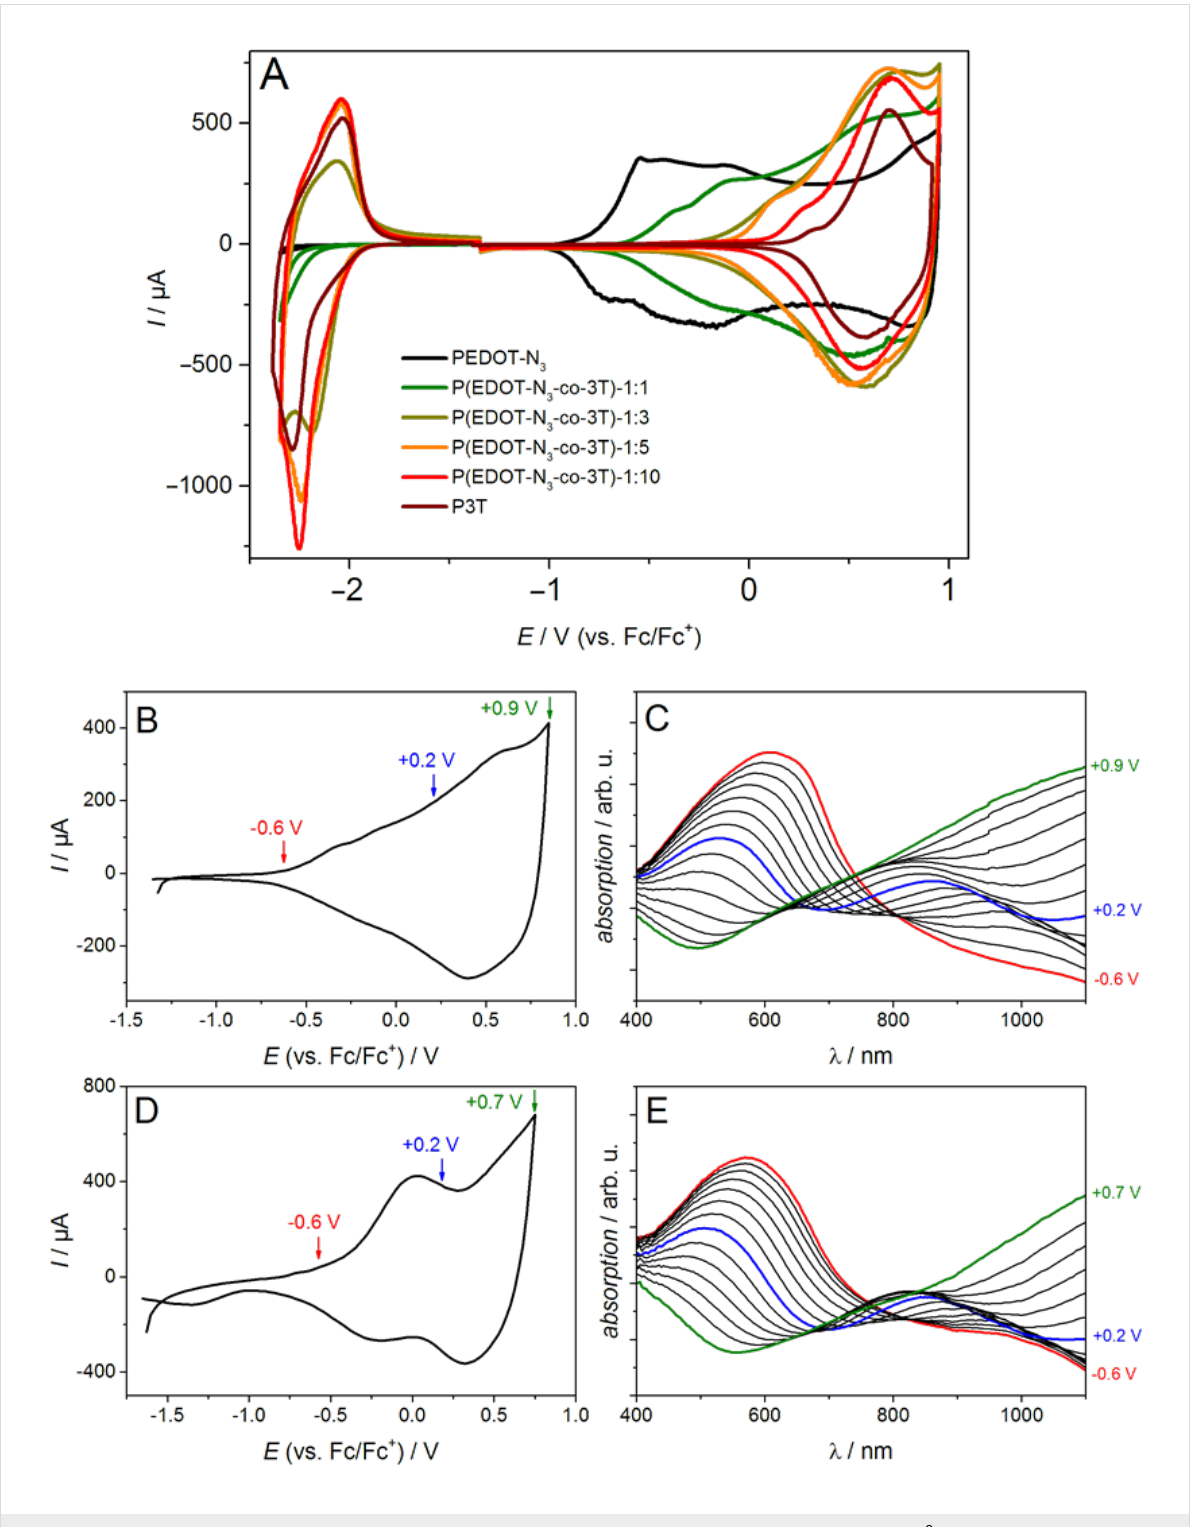
Figure 4: Cyclic voltammograms of films deposited under potentiostatic control on gold-coated glass substrates (1 cm 2 ) from different monomer mixtures: (A) Ratio of EDOT-N 3 :3T = 1:0 (black), 1:1 (dark green), 1:3 (light green), 1:5 (orange), 1:10 (red) and 0:1 (brown curve) recorded in 0.1 M NBu 4 PF 6 /MeCN, 20 mV/s. B–E: In situ spectroelectrochemistry of films deposited under potentiostatic control on ITO in 0.1 M NBu 4 PF 6 /MeCN. Cyclic voltammograms (B and D) and corresponding vis–NIR spectra (C and E) recorded during the forward scan of the oxidation of the P(EDOT-N 3 -co- 3T)- 1:1 (B and C) and P(EDOT-clickSO 3 Na -co- 3T)-1:1 (D and E) at 50 mV s − 1